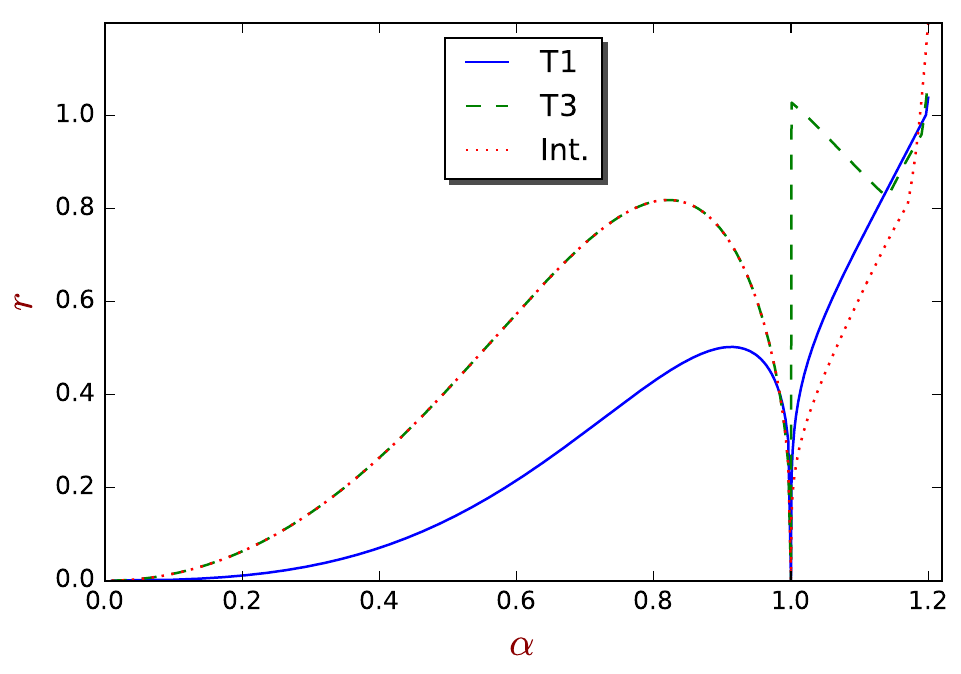
Fig. 6 Spectral radius of the AM6 methods for T1, T3 and interpolation